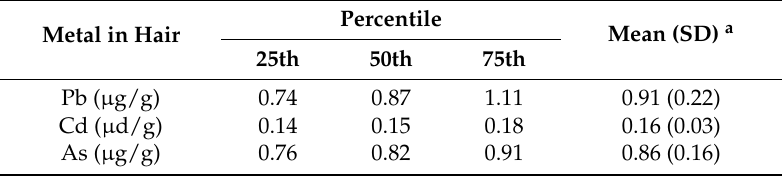
Table 2. The Distribution of Pb, Cd and As in hair of study population (n = 133). Metal in Hair